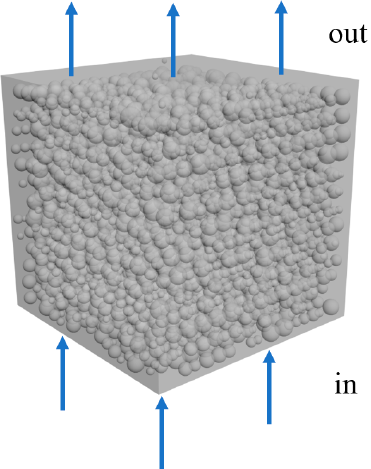
Figure 8. Diagram of flow field.